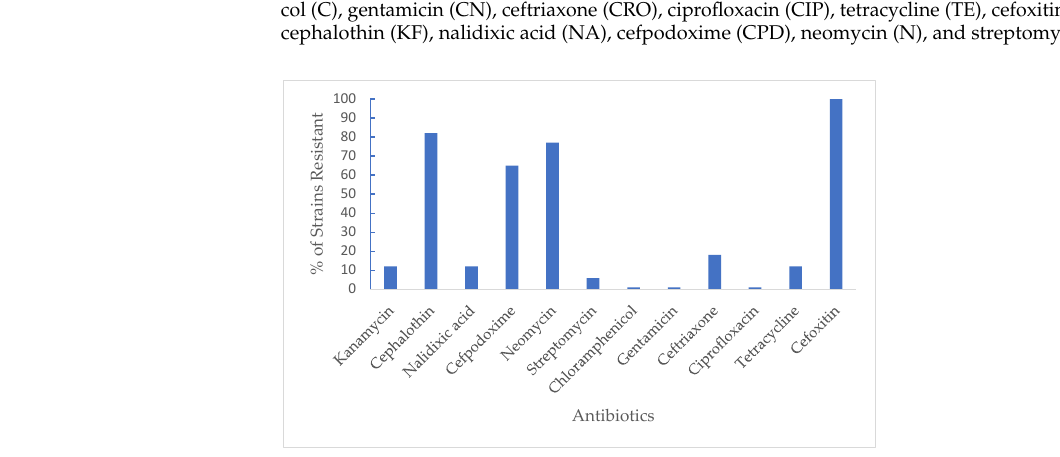
Figure 3. Sensitivity of Enterobacteriaceae strains to antibiotics.